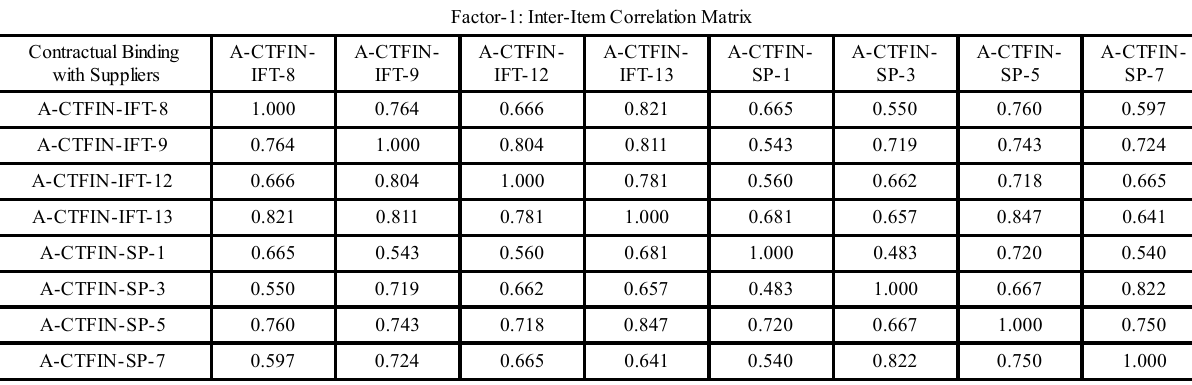
TABLE 17. FACTOR-1; DETAILS OF ITEM-TOTAL STATISTICS